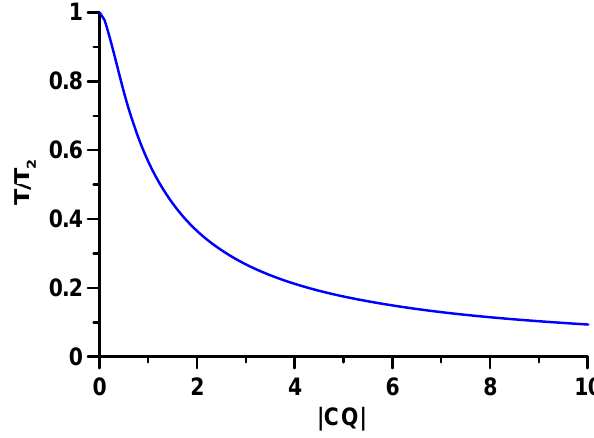
Figure 2. Breaking time versus CQ (T 2 is the breaking time in a purely quadratic medium) Fig. 2. Breaking time versus CQ ( T 2 is the breaking time in a purely quadratic